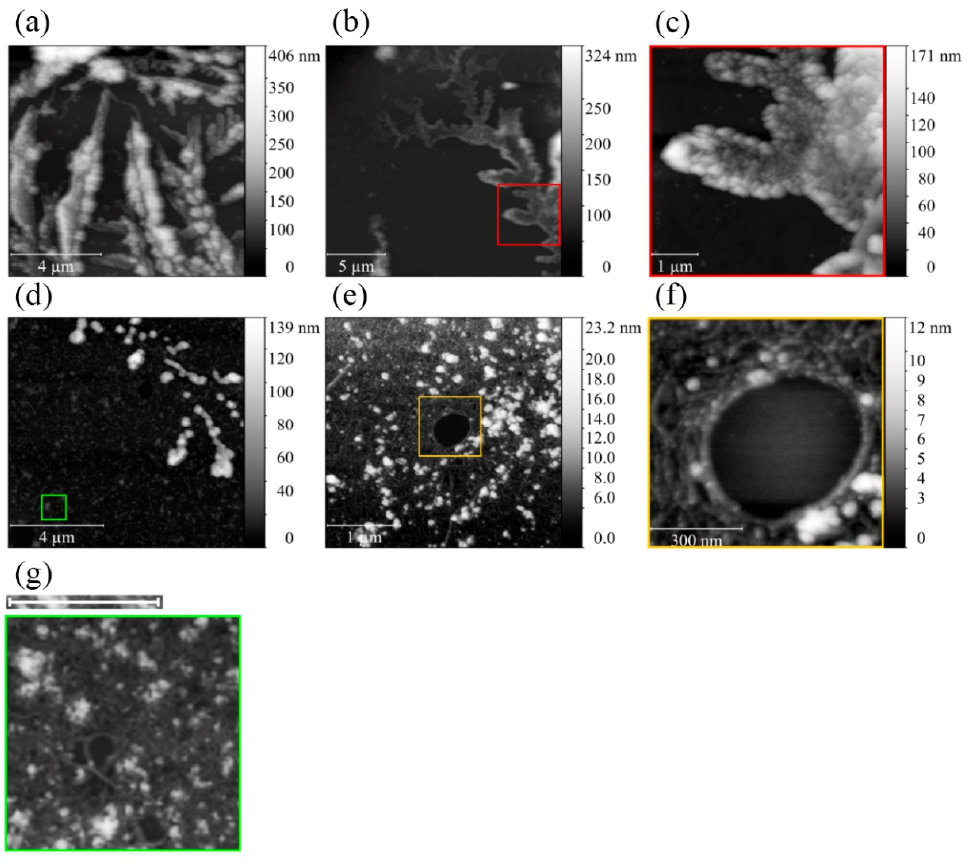
Figure 4. Atomic-force microscopy of SMT HMW aggregates in a solution containing 0.15 M glycine and pH 7.0–7.5. ( a ) SMT HMW after 1 h aggregation. ( b , c ) SMT HMW after 24 h aggregation. ( d , g ) SMT HMW aggregates after 1 h disaggregation; ( e , f ) SMT HMW aggregates after 24 h disaggregation. Scale bar in ( g ), 1 µm. The most representative data, obtained as a result of 3 independent experiments, are given.